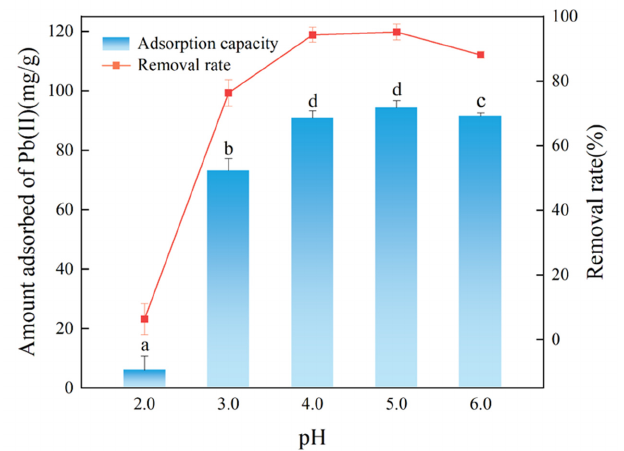
Figure 4. The effect of pH value on Pb(II) adsorption by FM-BC. Different letters indicate significant differences ( p < 0.05).